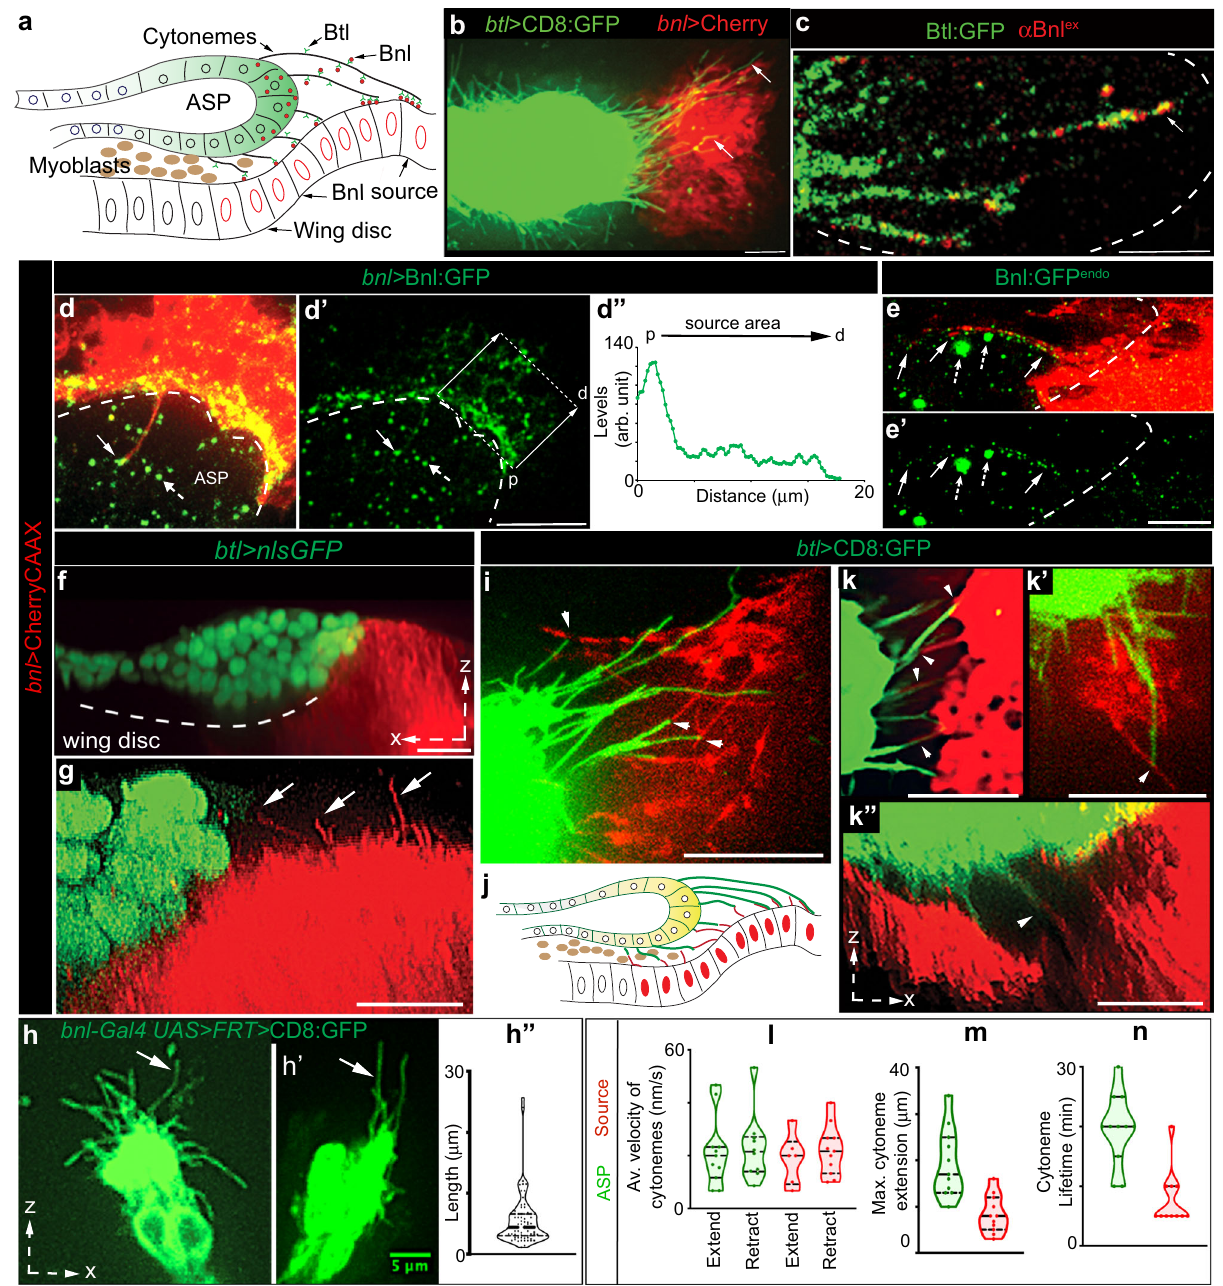
Fig. 1 The reciprocal polarity of Bnl presentation and reception via cytonemes. a Drawing depicting the organization of the ASP, wing disc, myoblasts, and Btl-containing ASP cytonemes receiving Bnl from the disc bnl source. b Spatial organization of the wing disc bnl -source ( bnl-LexA,LexO-mCherryCAAX ) and ASP ( btlGal4,UAS-CD8:GFP ) cytonemes (arrow). c – e ’ Polarized Bnl presentation from the source orienting toward the ASP; c polarized clustering of externalized Bnl ex (red; α Bnl ex ) at the contact sites of the unmarked source (dashed lined area) and Btl:GFP-containing ASP cytonemes (Btl:GFP - btl:GFP fTRG , see Supplementary Table 4); d , d ’ , e , e ’ polarized cytoneme-mediated presentation of overexpressed Bnl:GFP (d-d ” ; UAS- mCherryCAAX/ + ; bnl-Gal4/ UAS -Bnl:GFP) and endogenous Bnl:GFP endo ( e , e ’ ; UAS- mCherryCAAX/ + ; bnl-Gal4/bnl:gfp endo ) from the mCherryCAAX-marked bnl- source, orienting toward the overlaying ASP (dashed line); dashed arrow, Bnl:GFP puncta in internalized vesicles 9 within the ASP (dashed line); arrow, Bnl:GFP puncta on source cytonemes; e , e ’ airyscan image; d ” Bnl:GFP intensity plot within the boxed source area in d ’ along the proximal (p)-to-distal (d) direction (arrows) relative to the ASP, showing selective enrichment of the overexpressed signal toward the ASP. f – h ” 3D-rendered images showing the ASP- speci fi c polarity of source cytonemes (arrows); f , g mCherryCAAX-marked source and nlsGFP-marked ASP ( btl-Gal4,UAS- nlsGFP/ + ; bnl-LexA,LexO - mCherryCAAX/ + ); h , h ’ CD8:GFP-expressing mosaic clones within the bnl source area (see Methods); h ” violin plot displaying the source cytoneme length distribution (see Supplementary Fig. 1d). i – n Contact-dependent reciprocal guidance of source (red) and ASP (green) cytonemes ( btl-Gal4,UAS- CD8:GFP/ + ; bnl-LexA,LexO -mCherryCAAX/ + ); arrowhead, contact site; j illustration of i – k ” ; l – n violin plots displaying ASP (green) and source (red) cytoneme dynamics as indicated (also see Supplementary Fig. 1e – h and Supplementary Table 1 for statistics). All except c – e ’ , live imaging. Violin plots: black dotted lines - median and 25th and 75th percentiles. Source data are provided as a Source data fi le. Scale bars, 20 μ m; 5 μ m ( e , e ’ , h , h ’ ).